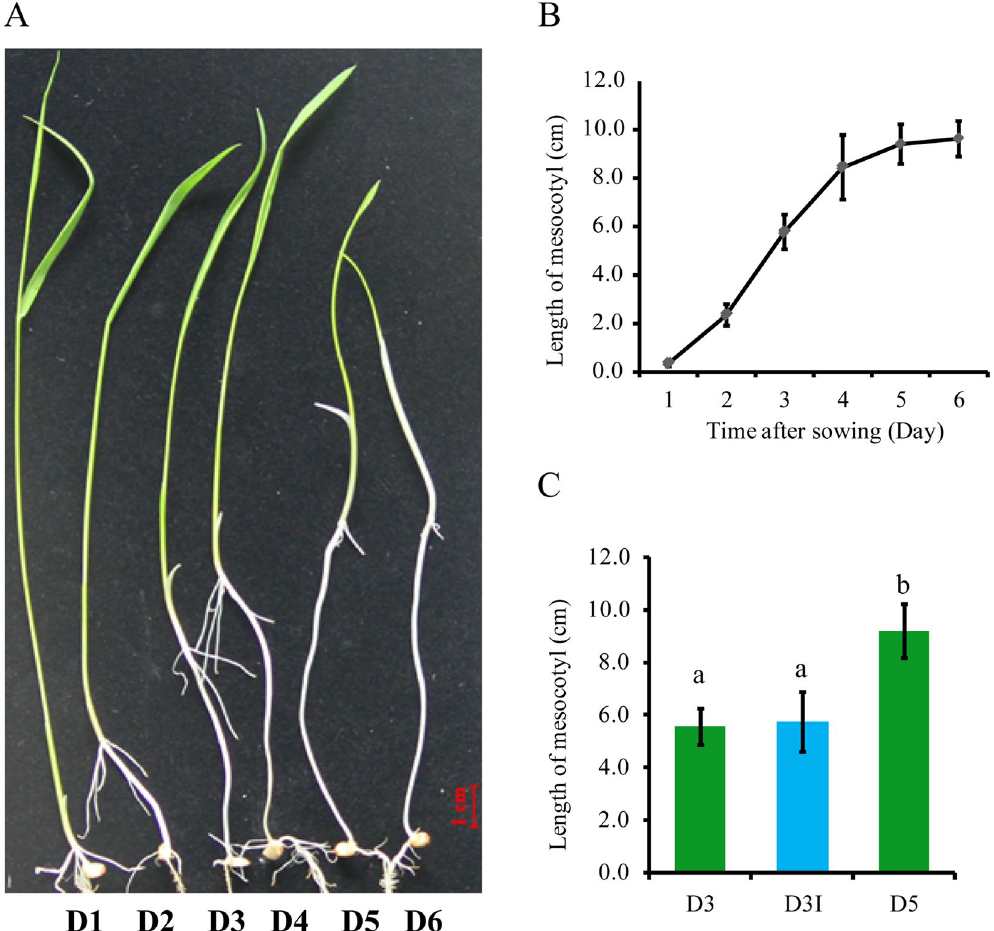
Figure 1. Time-course of mesocotyl elongation of dark-grown ZXM seedlings. ( A ) Seedlings of ZXM exposed to white light since the indicated number of days after sowing; ( B ) Mesocotyl lengths of the seedlings; ( C ) For light interruption experiments, 3-day-old dark-grown ZXM seedlings were irradiated with white light for one minutes and then kept in ongoing darkness for another two days. a and b indicate a significant difference at P < 0.01 between the compared pairs. The data represent mean ± SD, n =